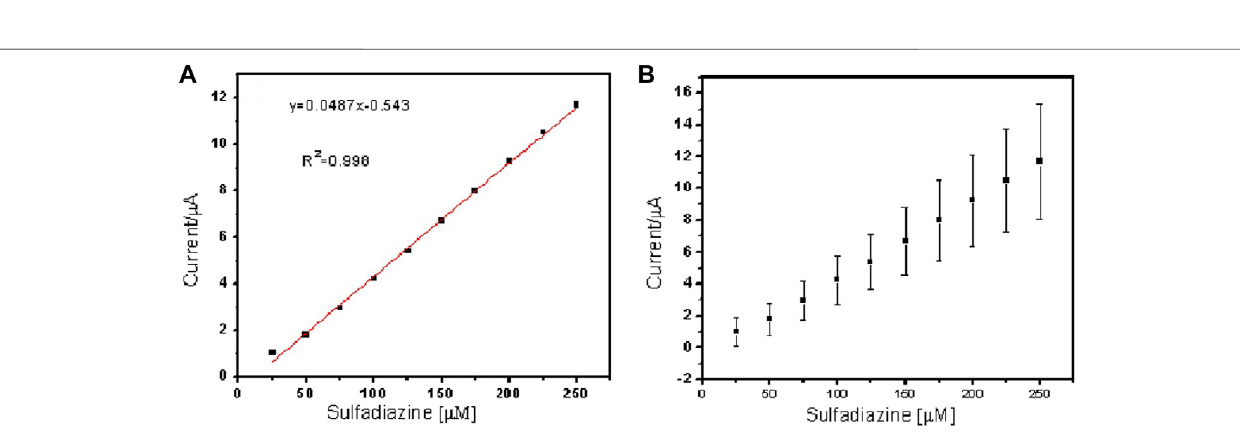
Frontiers in Chemistry |